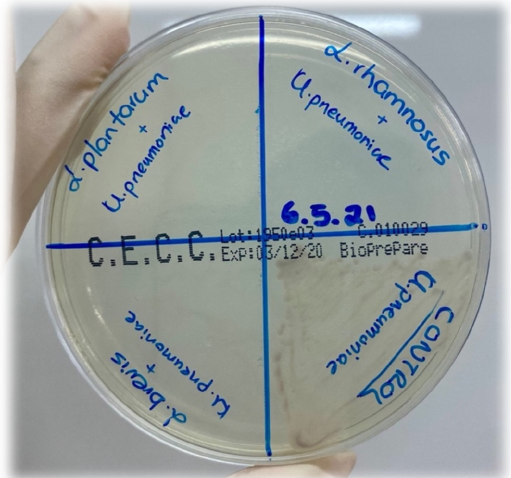
Figure 7. The results of the antimicrobial activity of CFCs (after 5 days incubation) of three LAB species ( Levilactobacillus brevis, Lactiplantibacillus plantarum, Lacticaseibacillus rhamnosus ) against pathogenic bacteria Kl. Pneumoniae ATCC700603.